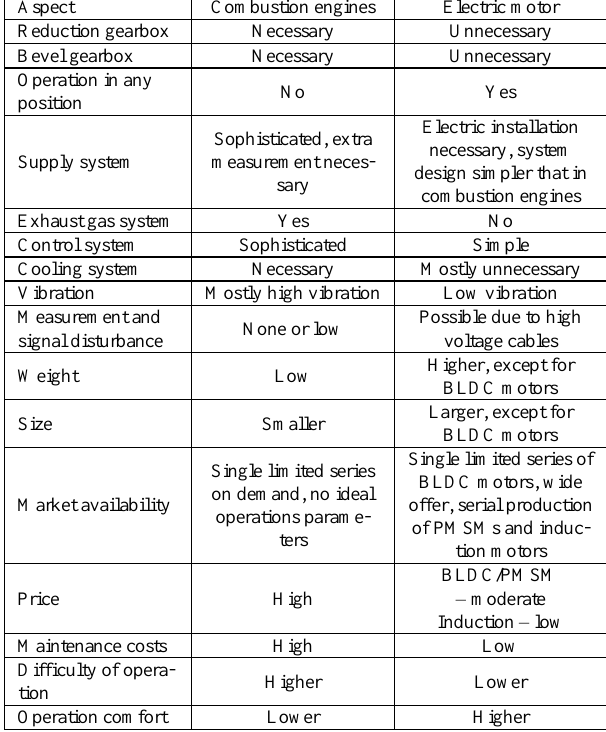
Table 3. Advantages and disadvantages of selected